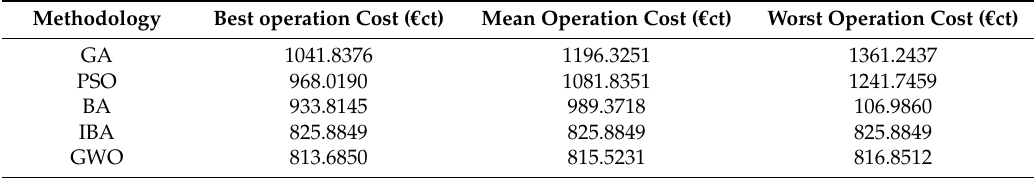
Table 2. Demonstration of operation dispatch costs of the microgrid in Scenario A.